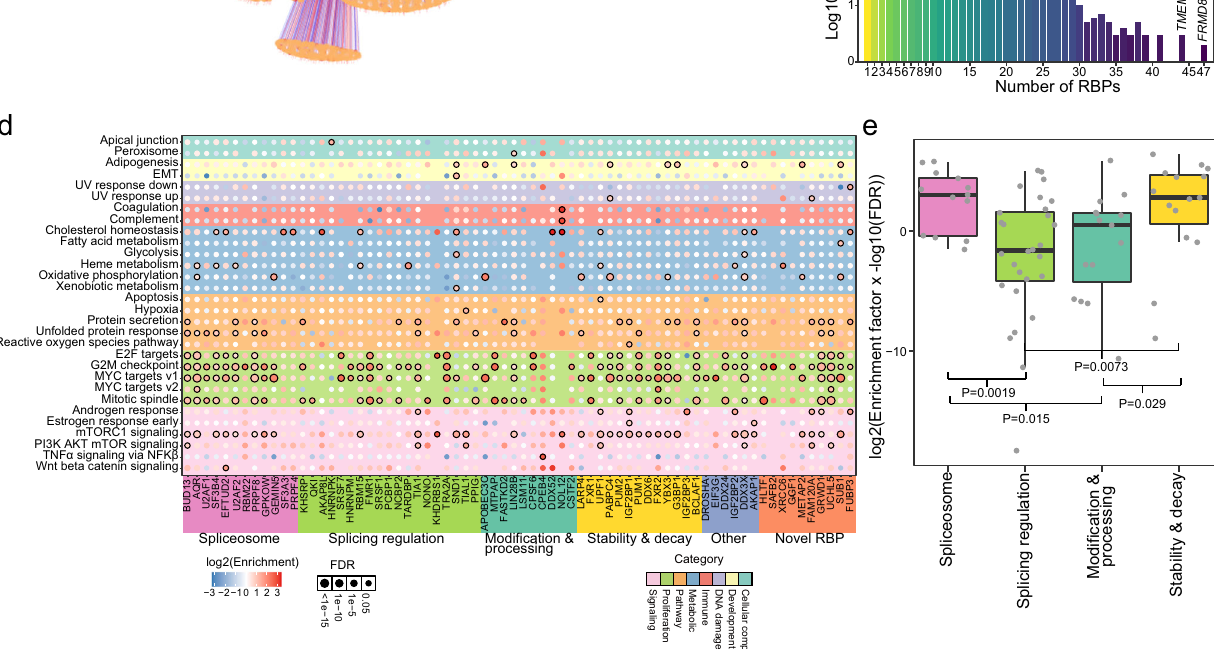
Fig. 3 | The regulation of transcripts by RBPs. a The regulatory network of RBPs and transcripts. b The numbers of regulated transcripts for each RBP. c The num- bers of transcripts regulated by different numbers of RBPs. d The bubble plot shows the enrichment of regulated transcripts in biological hallmarks across dif- ferent RBPs. Bubbles with FDR values <0.05 are labeled with black borders.